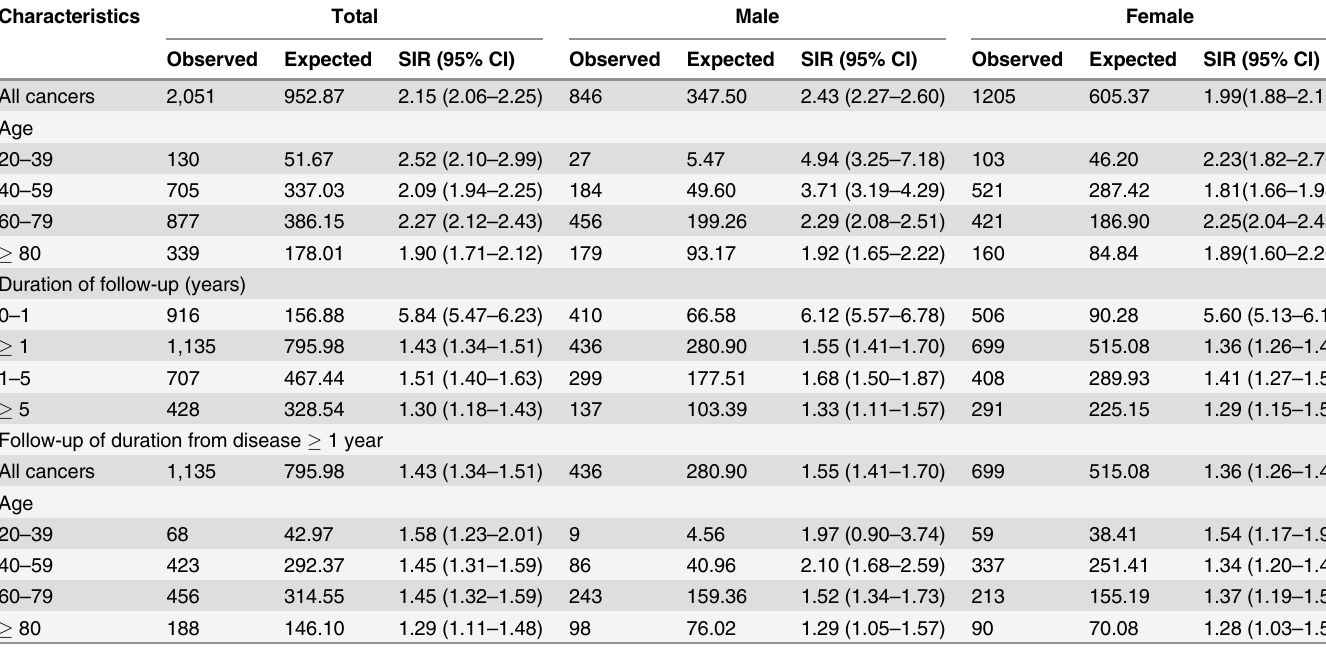
Table 2. Standardized incidence ratios (SIRs) according to sex, age at diagnosis, and duration of follow-up.